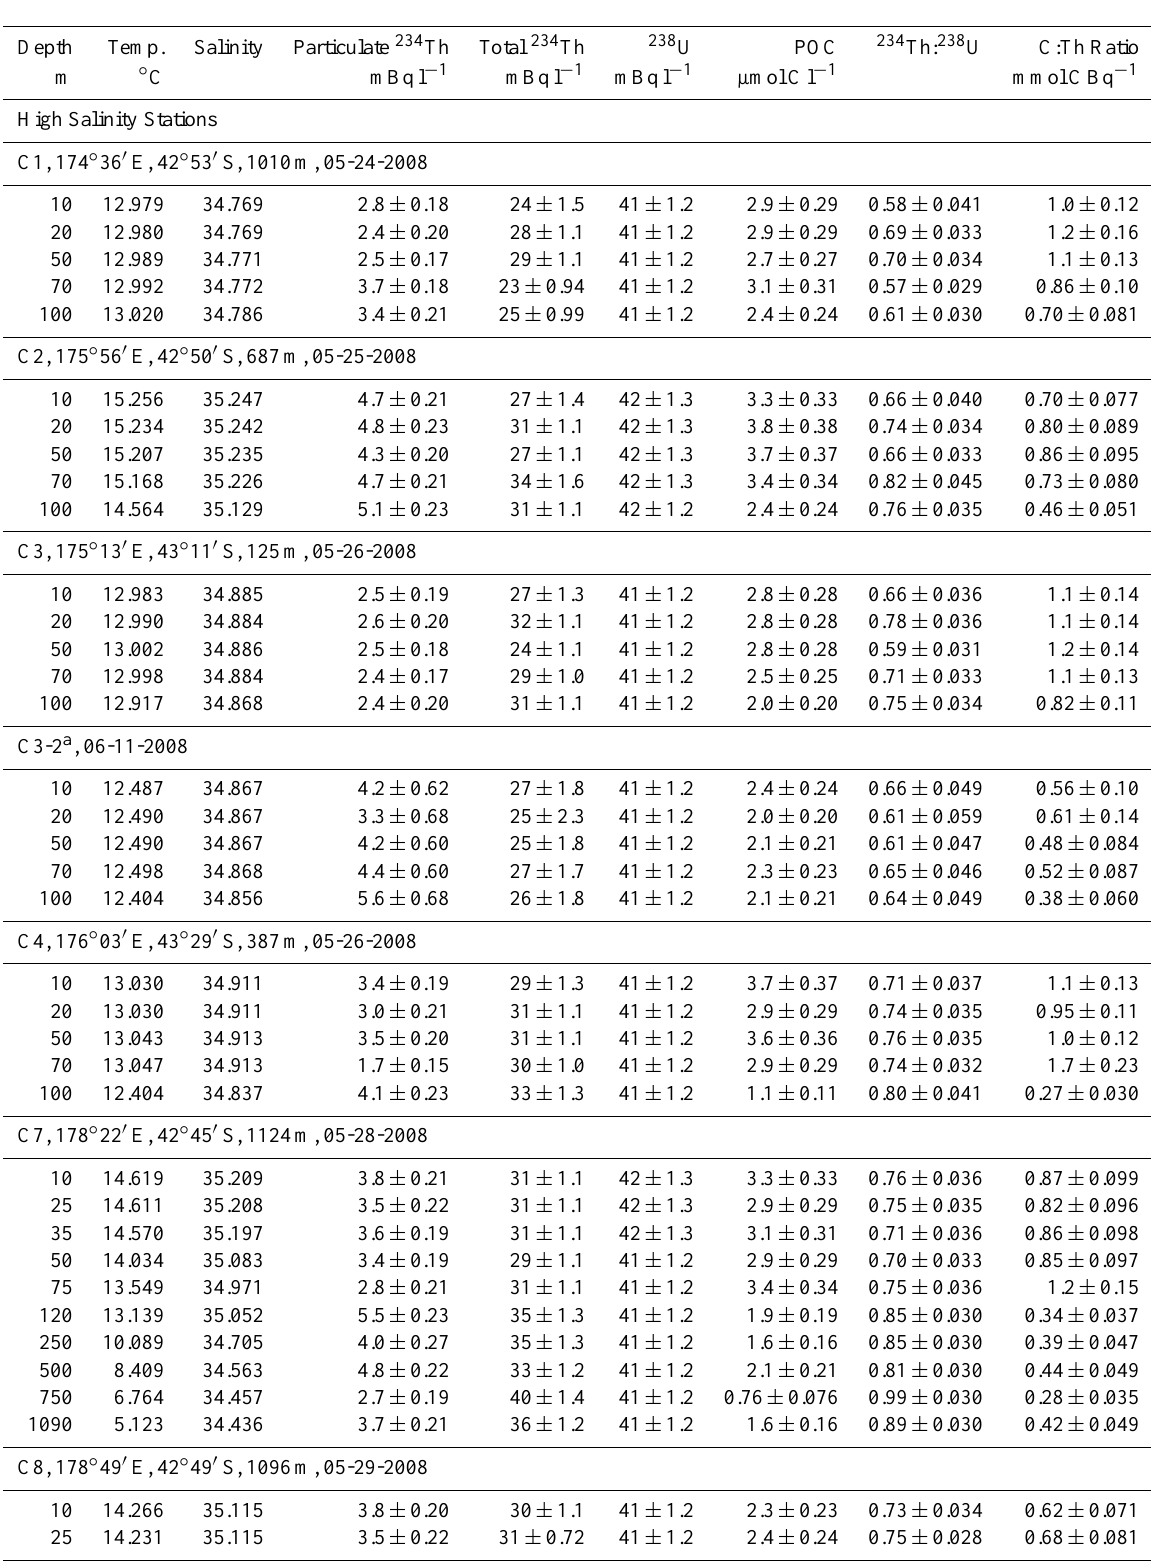
Table 1. Temperature, Salinity, Particulate and Total 234 Th activities, 238 U activities, 234 Th: 238 U and POC: 234 Th ratios for all stations in the Subtropical Front, Chatham Rise, New Zealand, measured in May–June 2008 (NIWA cruise TAN0806). Depth